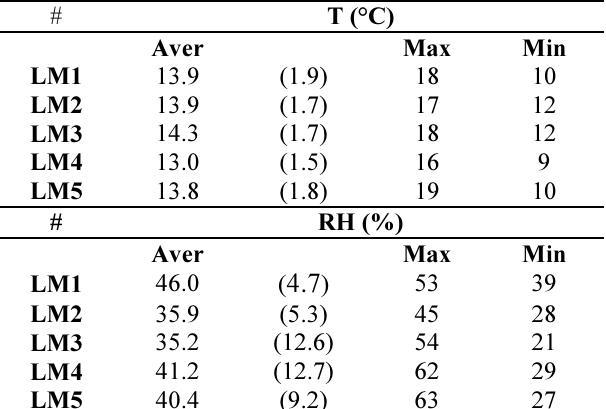
Table 2. Average temperature and relative humidity (4 months), Max and Min. Numbers in brackets are standard